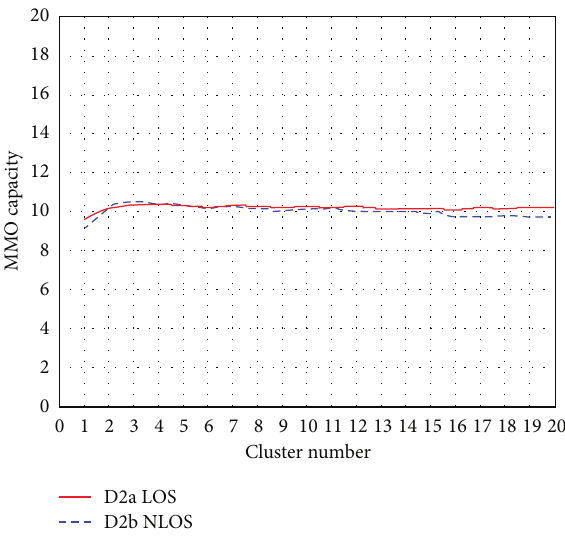
F 9: Eigenvalues comparison in